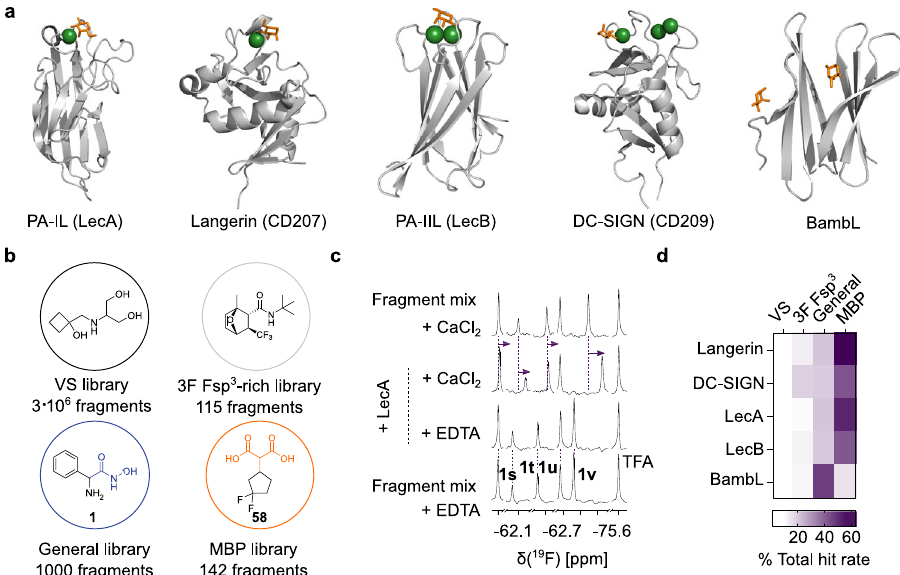
Fig. 1 Druggability assessment of metal-dependent lectins. a Cartoon representation of monomer crystal structures showing the carbohydrate- recognition domain (CRD) bound to the monosaccharides ( orange ) in a Ca 2 + -dependent manner ( green spheres ): LecA (D-galactose, PDB: 4CP9), Langerin (D-mannose, PDB: 3P5D), DC-SIGN (D-mannose, PDB: 1SL4), LecB (L-fucose, PDB: 5A70). BambL does not require Ca 2 + for carbohydrate binding (L- fucose, PDB: 3ZZV). b All targets were screened computationally and experimentally using 3F Fsp 3 , general and MBP libraries. c Shown are 19 F T 2 - fi ltered NMR spectra of a fragment mixture of the MBP library in the presence of 5 mM EDTA alone or with 20 µ M LecA followed by competition with 30 mM CaCl 2 . The fragments undergoing a chemical shift perturbation (CSP) above 0.01 ppm ( violet arrow ) in the presence of LecA and CaCl 2 indicated a Ca 2 + - dependent binding. d Heat map shows the percentage values (%) of total hit rates of four libraries screened against fi ve lectins revealing that MBP library improved the hit rates for Ca 2 + -binding lectins (37 –